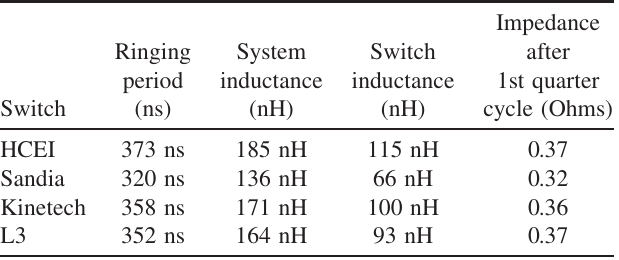
TABLE III. Gas switch short-circuit parameters for (cid:2) 60 - kV charge voltages on 38 nF capacitors obtained from data shown in Fig. 14.